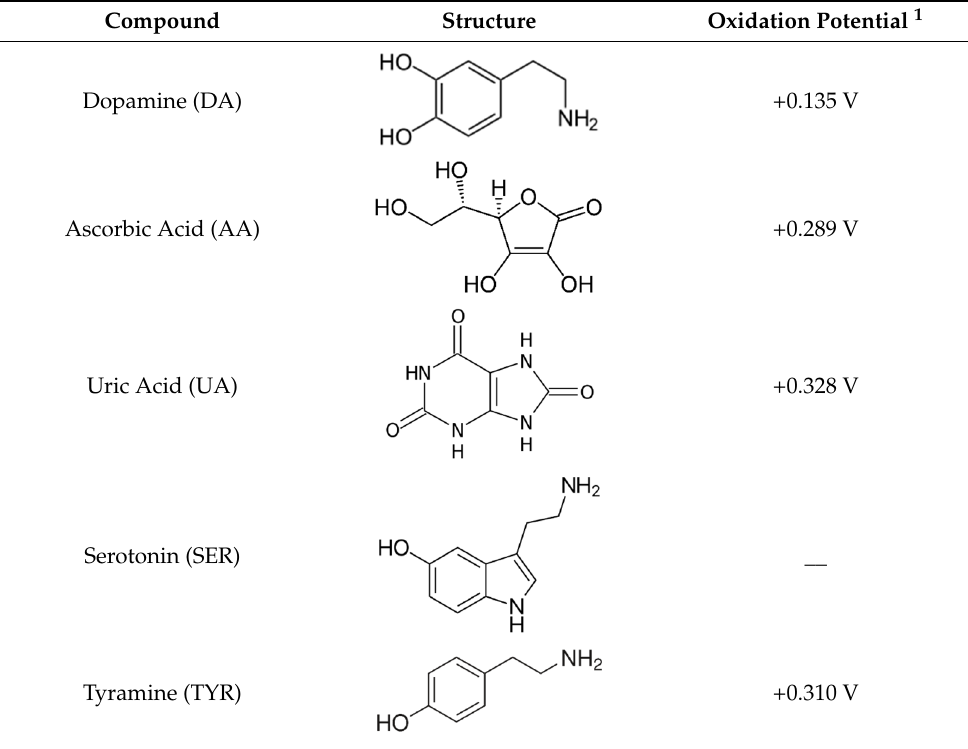
Table 1. Oxidation potentials of dopamine and possible competitive molecules at a bare Pt electrode.